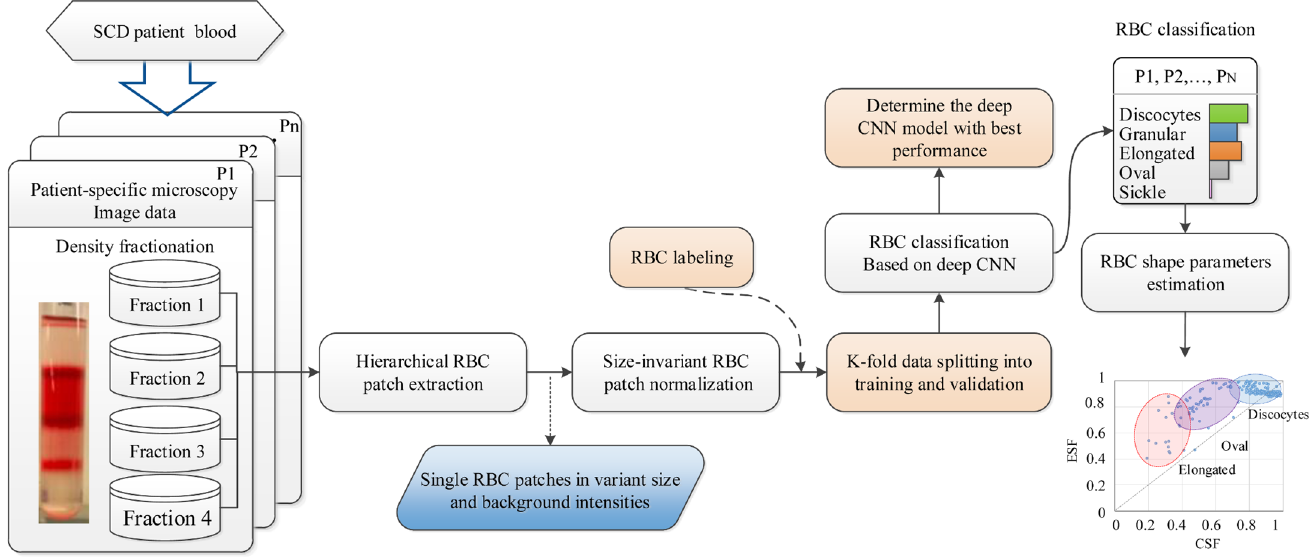
Fig 1. Overall flowchart of our proposed training and learning methodology for the sickle RBC-dCNNclassification model describing the four main steps, including an independent shape factor analysis.